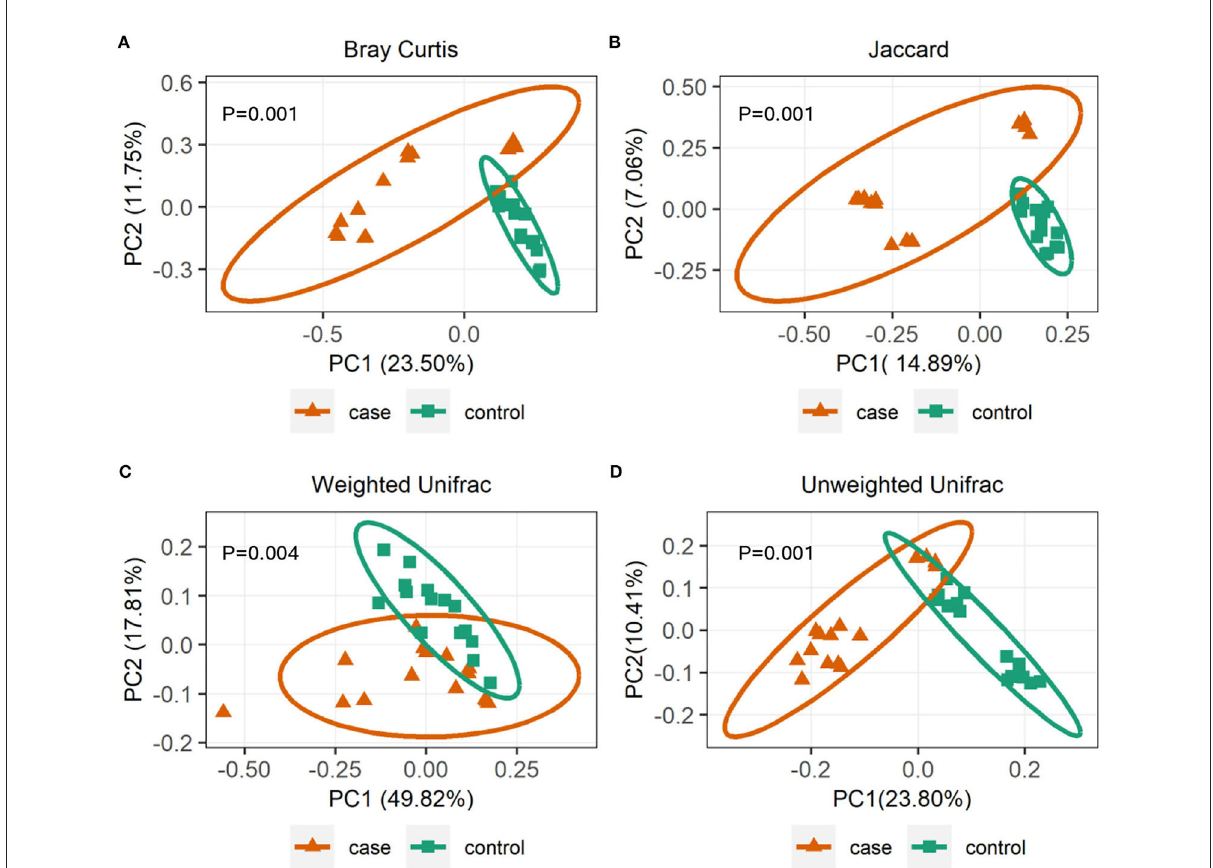
FIGURE2 Gut microbial beta diversities analysis. Principal coordinate analysis (PCoA) plots based on community membership as measured by the Bray-Curtis distances (A) , Jaccard distances (B) , Weighted UniFrac distances (C) , and Unweighted UniFrac distances (D) . Orange triangles and blue squares circle represent case and control yaks,